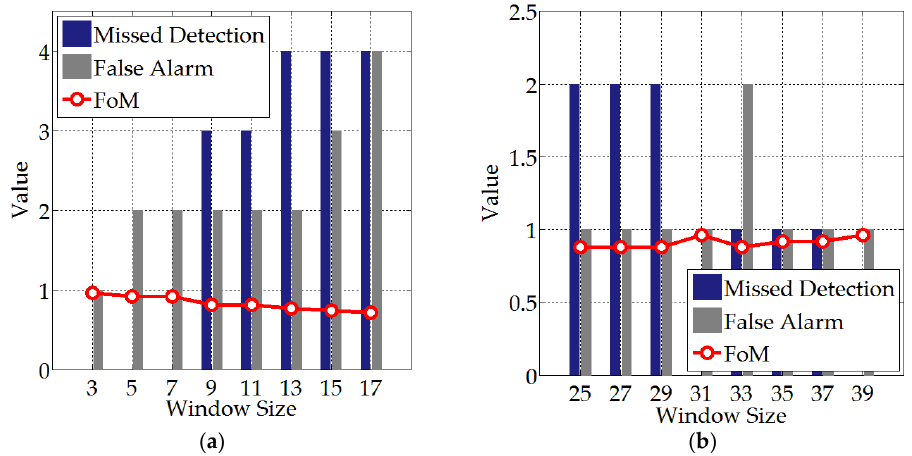
Figure 8. The impact on detection performance under different window sizes. ( a ) Size change of test window with a fixed guard window size (31 × 31 pixels). ( b ) Size change of guard window with a fixed test window size (3 × 3 pixels).